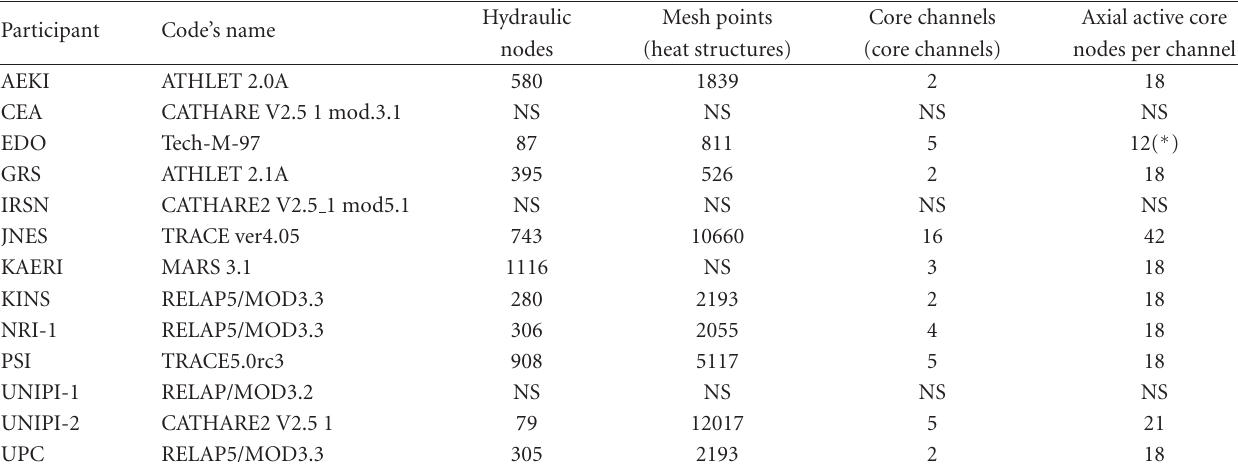
Table 3: Nodalization resources used by each